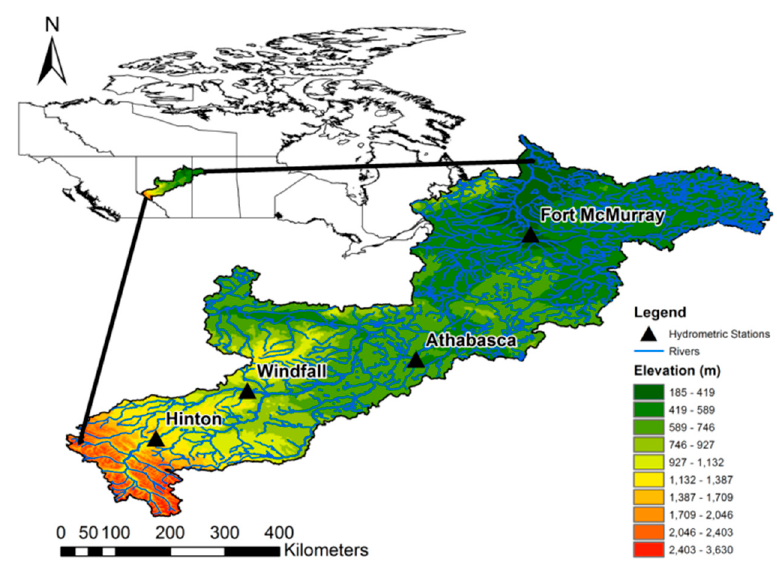
Figure 1. Athabasca watershed with its elevation range and the Athabasca River network, including the locations of the four hydrometric stations used for flood frequency analysis.